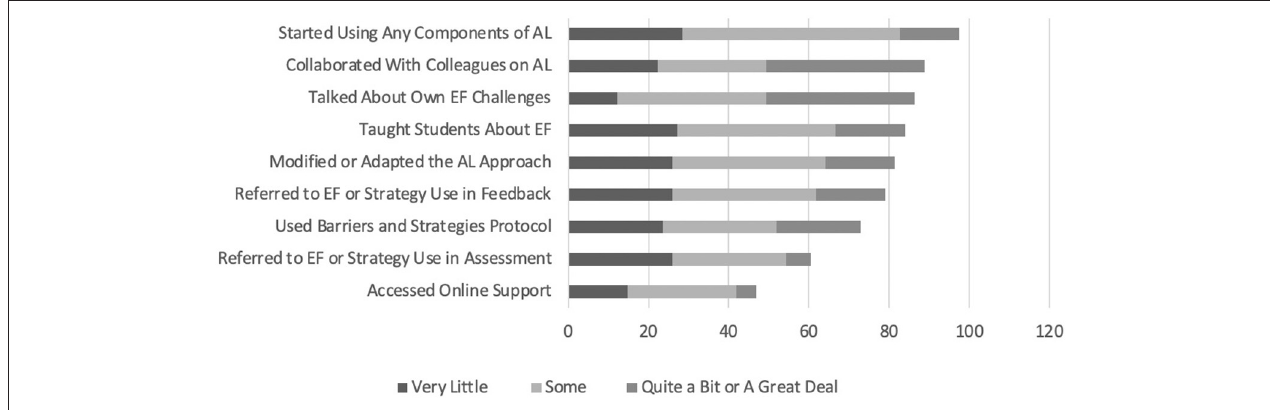
FIGURE 1 | Percent implementation across all